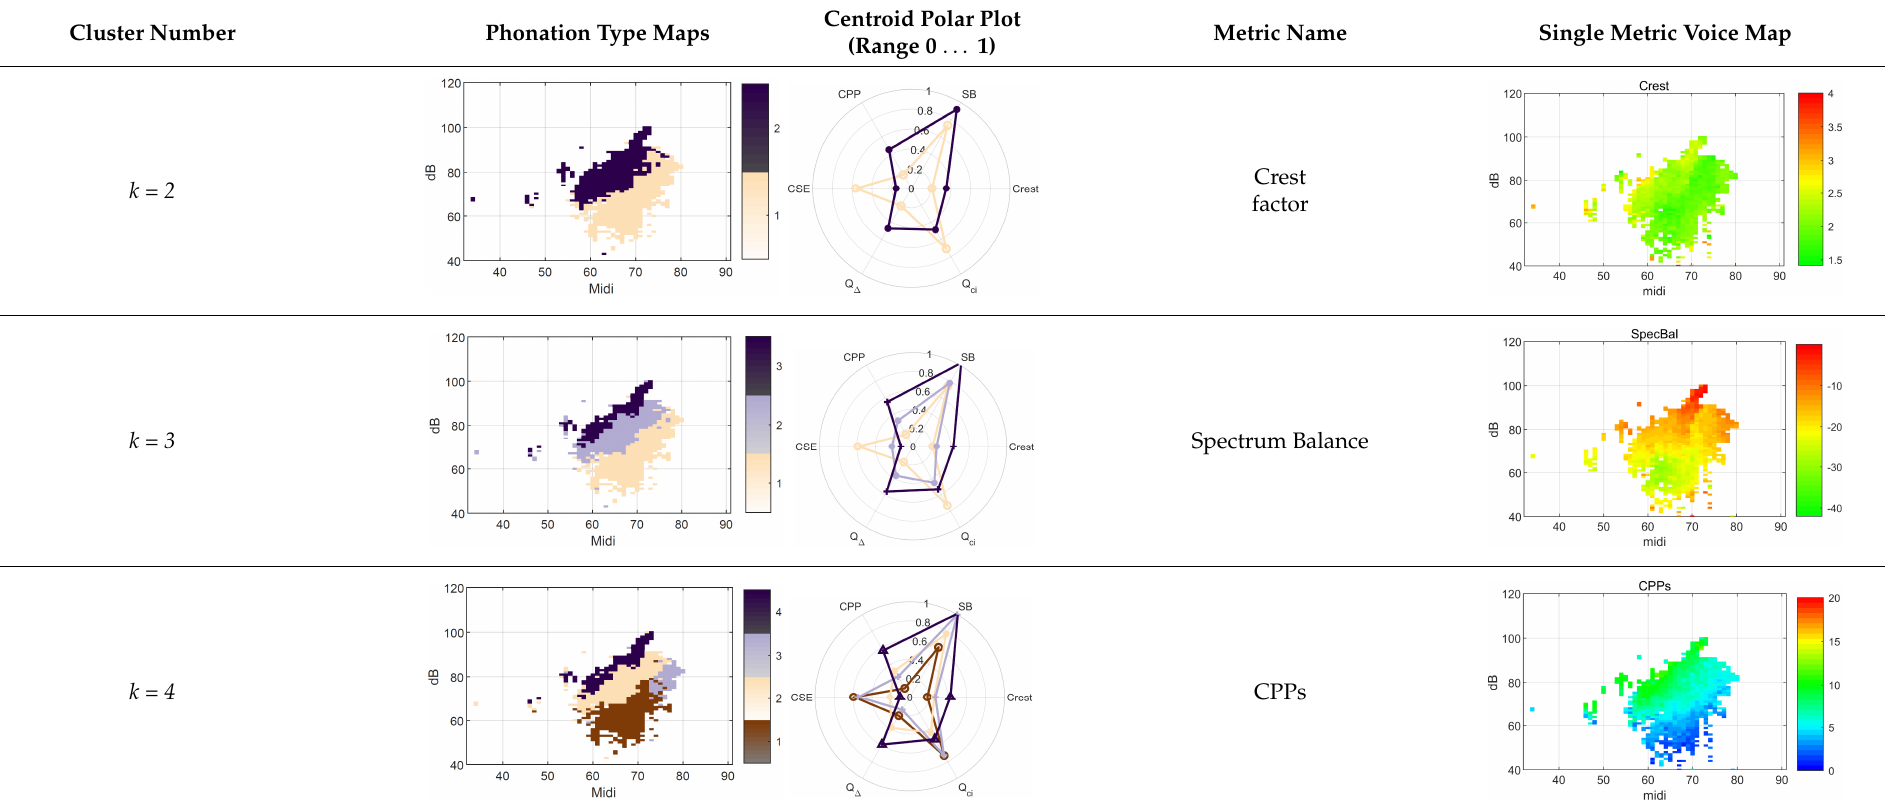
Table A3. Child participant B09.